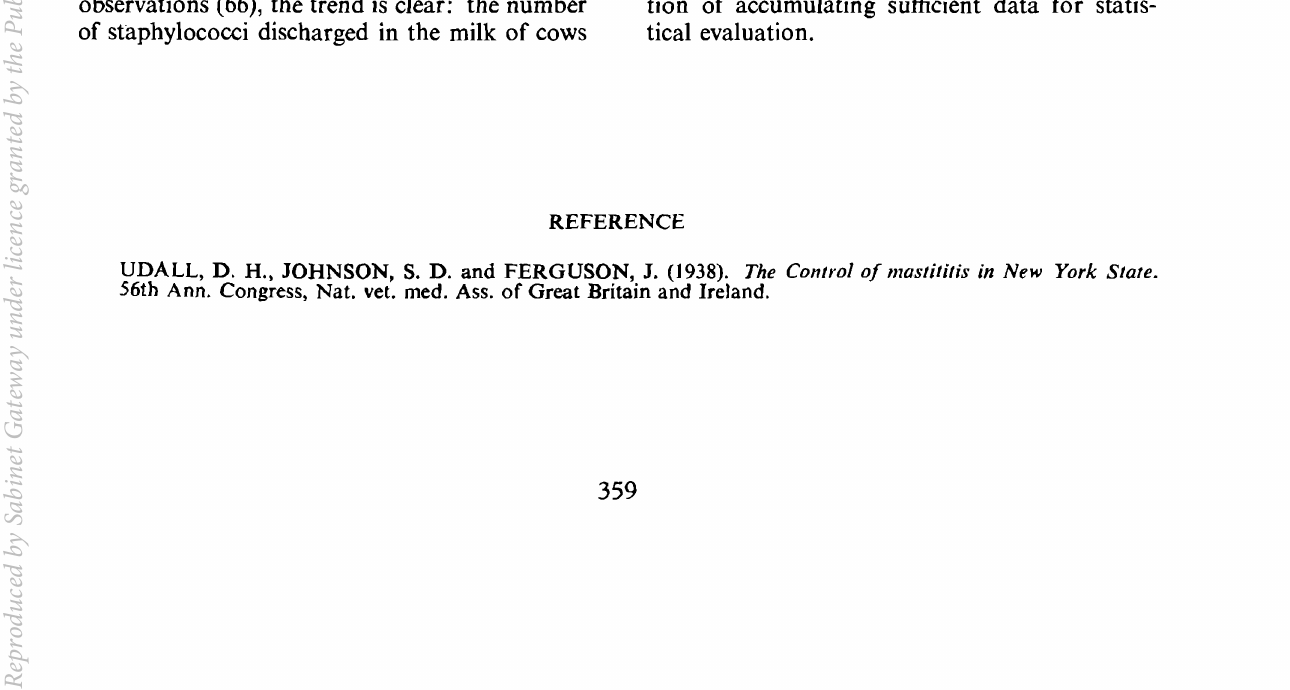
TABLE 2.-AvERAGE NUMBER OF STAPHYLOCOCCI IN MILK IN RELATION TO WHITE CELL COUNT No. of leucocytes in I mm" of